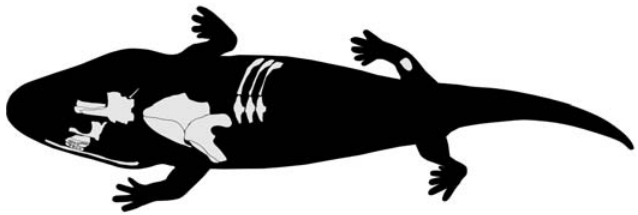
Fig. 2. Preserved elements of Parapytanga catarinensis gen. et sp. nov. (holotype, UFRGS-PV-0355-P) from the Santa Catarina State (Brazil), Middle–Upper Permian.